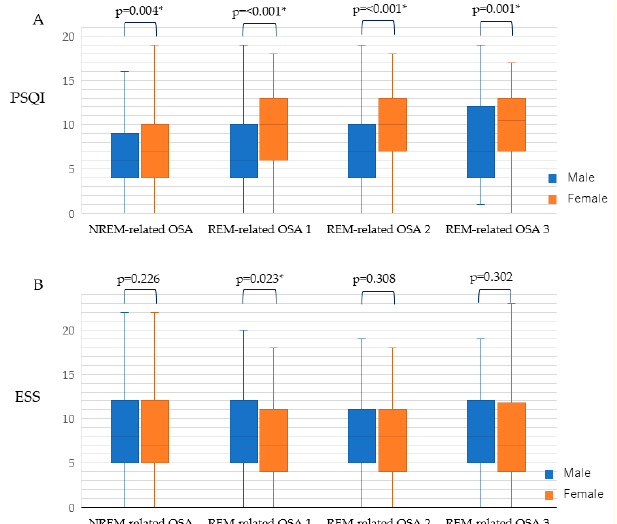
Figure 2. Gender di ff erence in relation to ( A ) PSQI and ( B ) ESS for NREM-related OSA and REM-related OSA 1, 2, and 3. Date are shown as box plots (the central line of the box represents the median; the lower and upper limits of the box represent the 25th and 75th percentiles, respectively, and the whiskers represent the minimum and maximum). PSQI, Pittsburgh Sleep Quality Index; ESS, Epworth Sleepiness Scale; p < 0.05